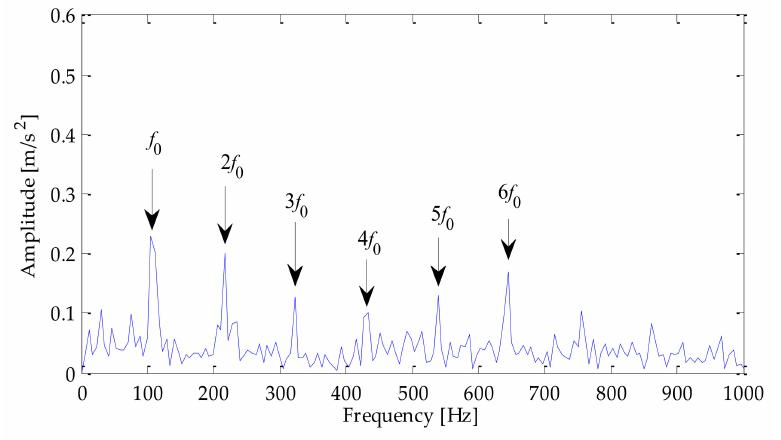
Figure 44. Analysis of signal envelope spectrum after noise reduction based on